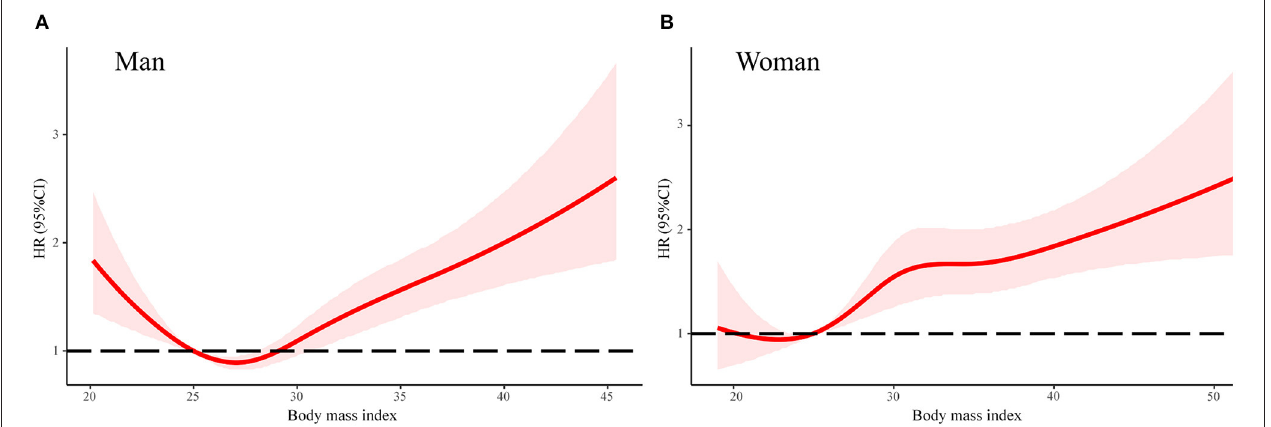
FIGURE 3 | The association between body mass index and all-cause mortality in linear splines curve for men (A) and women (B) . Models were adjusted by age, sex, center-race, education ( < high school, high school, or > high school), annual household income ( < 16,000; 16,000–35,000; > 35,000 US$), heart rate, systolic blood pressure, total caloric intake, total cholesterol, high density lipoprotein cholesterol, low density lipoprotein cholesterol, triglycerides, creatinine, and blood glucose. CI, confidence interval. HR, hazard ratio. but this association was stronger in women than in